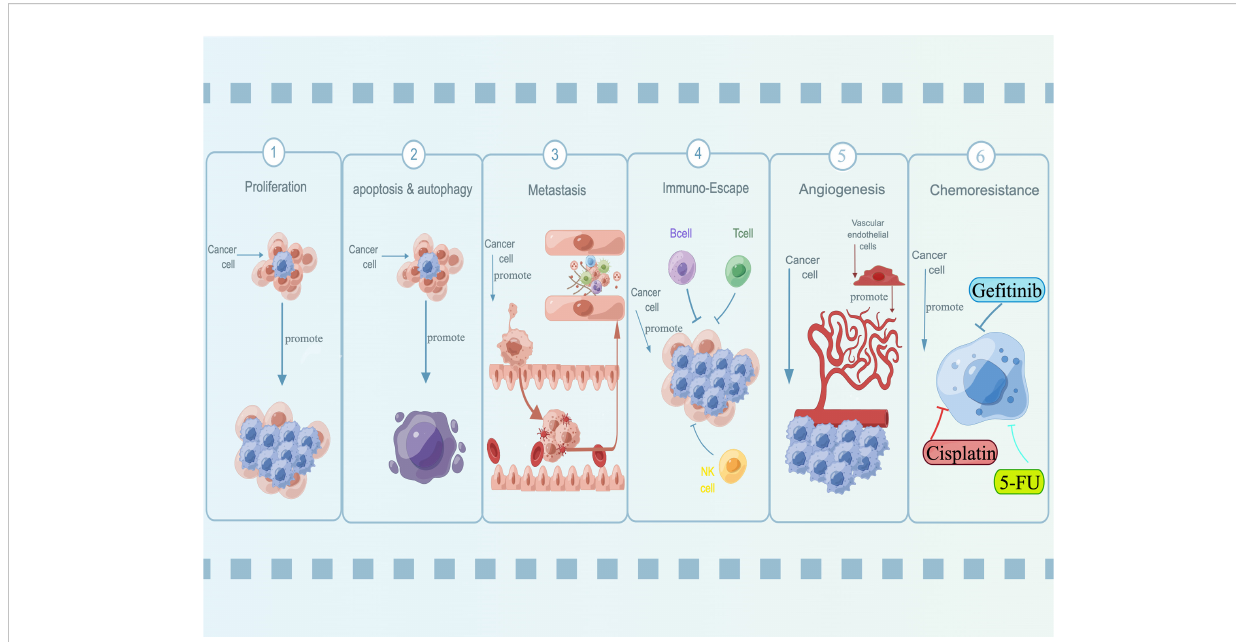
FIGURE 1 Oncogenic roles of lncRNA SNHG15 in a variety of diseases. SNHG15 has been identi fi ed for its fundamental role in regulating proliferation, apoptosis, autophagy, metastasis, immuno-escape, and